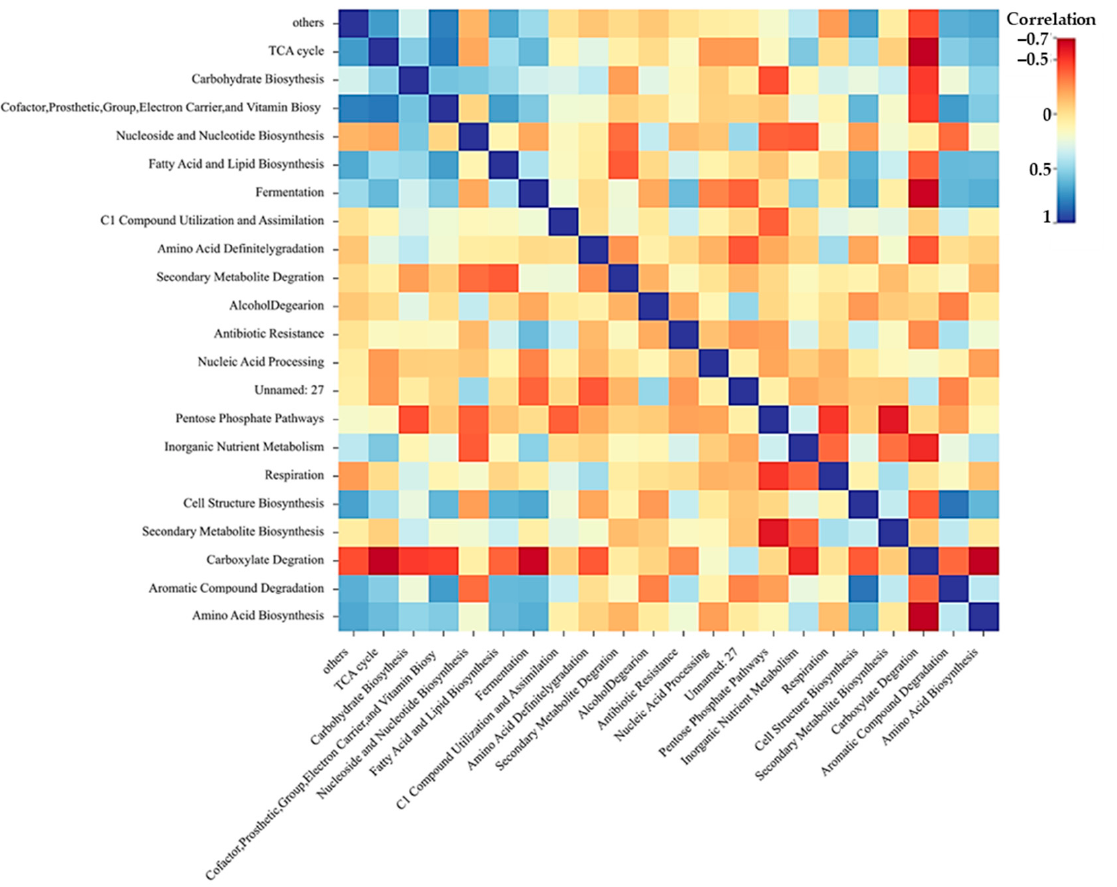
Figure 7. Formation correlation heat map. It can be understood that the correlation coefficient of Cofactor, Prosthetic, Group, Electron Carrier, and Vitamin Biosy and Aromatic Compound Degradation is 0.71, Cell Structure Biosynthesis and C1 Compound Utilization and Assimilation had a correlation coefficient of